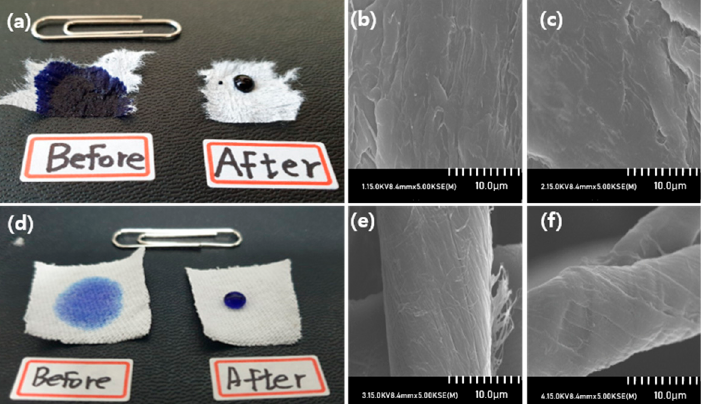
Figure 3. ( a ) Blue ink droplet on tissue paper before and after pV4D4-PFDMA coating; ( b ) SEM image of the tissue paper; ( c ) SEM image of the tissue structure after coating; ( d ) blue ink droplet on cotton fabric before and after pV4D4-PFDMA coating; ( e ) SEM image of the cotton fabric; and ( f ) SEM image of the cotton fabric after coating.